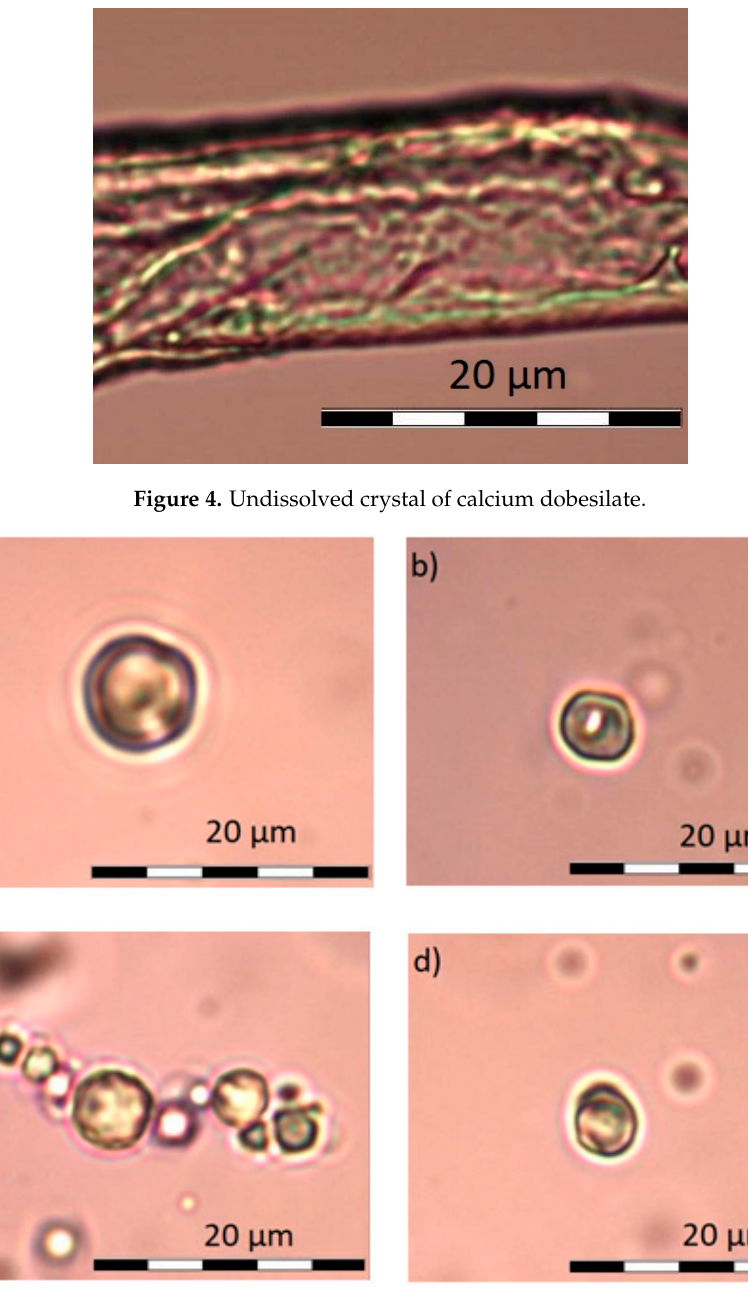
Figure 5. ( a ) liposomes D in zoom 400× ( b ) liposomes E in zoom 400× ( c ) liposomes F in zoom 400× ( d ) liposome G in zoom 400×.